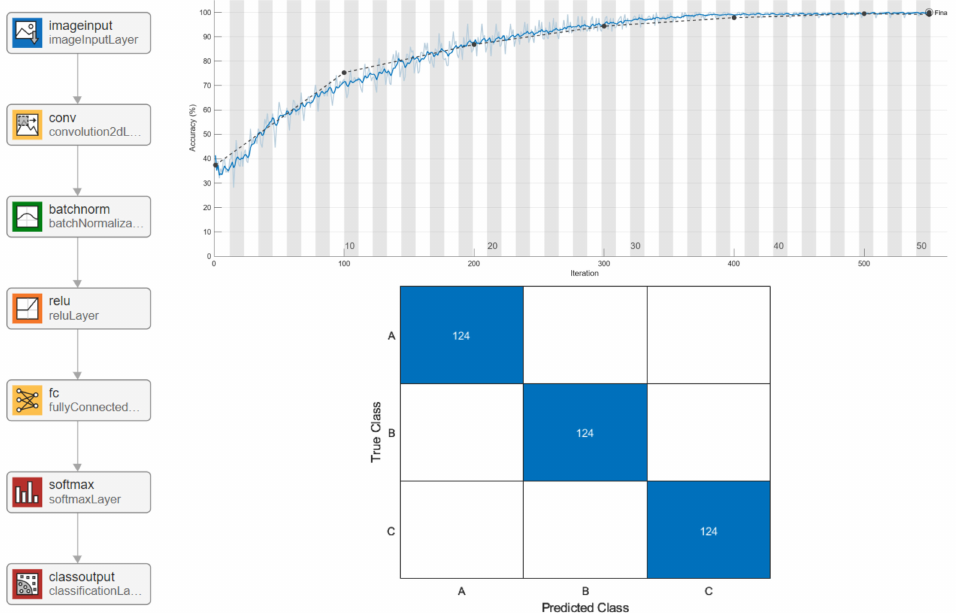
Figure 12. CNN structure ( left ), training process accuracy ( top right ) dark blue – training smoothed; light blue – training; dotted – validation; and test confusion matrix of the learnt CNN ( right bottom